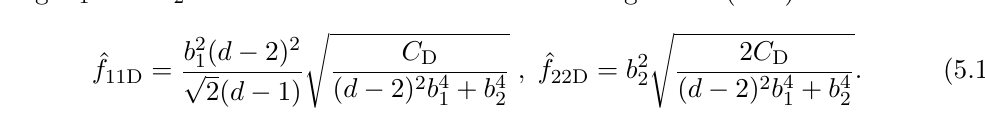
Figure 5. The maximum possible b ∆ Planes are inserted below points with the same value of a spectrum shown in the left columns in table